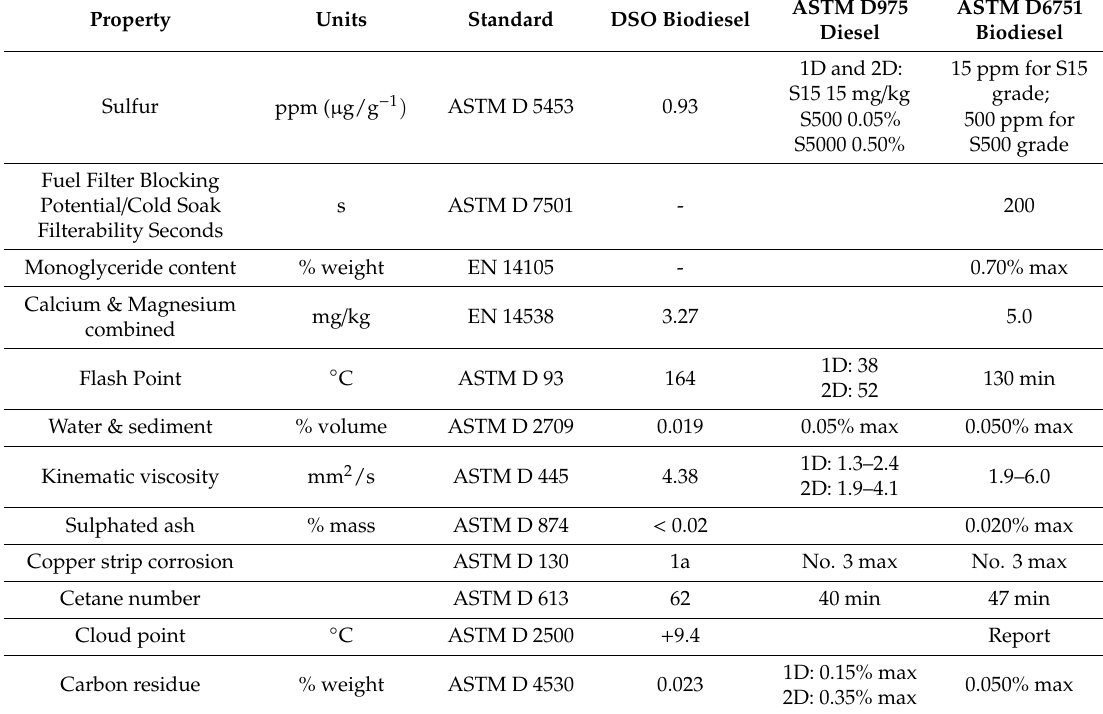
Table 9. Comparison of DSO biodiesel and di ff erent standards for biodiesel and petrol